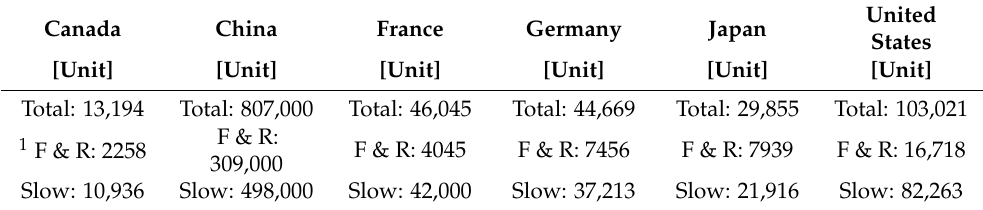
Table 4. Number of chargers in some